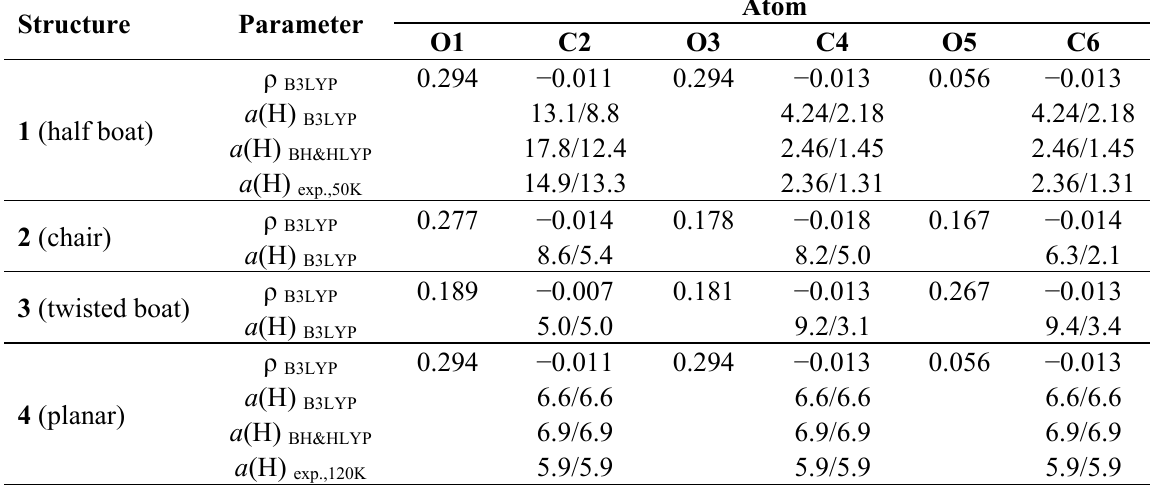
Table 1. Calculated values of the atomic spin densities ρ and of isotropic hfs splitting is given in Figure 2). Hfs splitting constants, determined in CF 3 CCl 3 matrix and assigned to